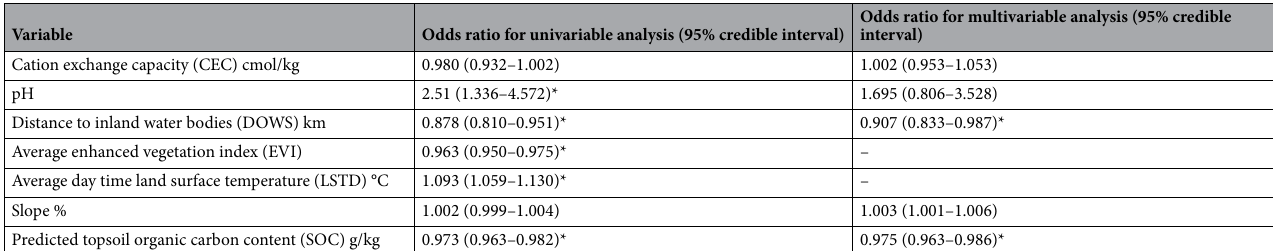
Table 3. The odds ratio of points falling into defined risk areas as explained by environmental variables. Results of univariable and multivariable analysis showing the association between the probability of high anthrax risk and environmental variables in the Ngorongoro Conservation Area. EVI and LSTD were excluded from the multivariable model due to a high degree of collinearity as indicated by a variance inflation factor > 3. (*) gives indication of an association (i.e. credible intervals excluding